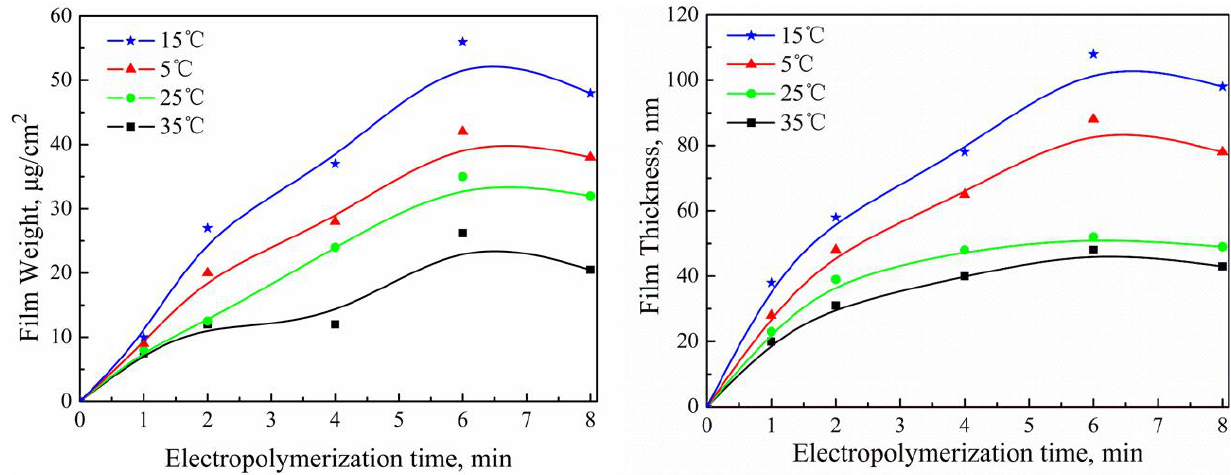
Figure 5. Effect of electropolymerization temperature on the film weight and thickness of PAF17 nanofilms. Electropolymerization conditions (Current density: 0.3 mA/cm 2 ; Concentration of AF17N: 5 mM; Electropolymerization temperature: 5, 15, 25 35 °C; Electropolymerization time: 1, 2, 4, 6, 8